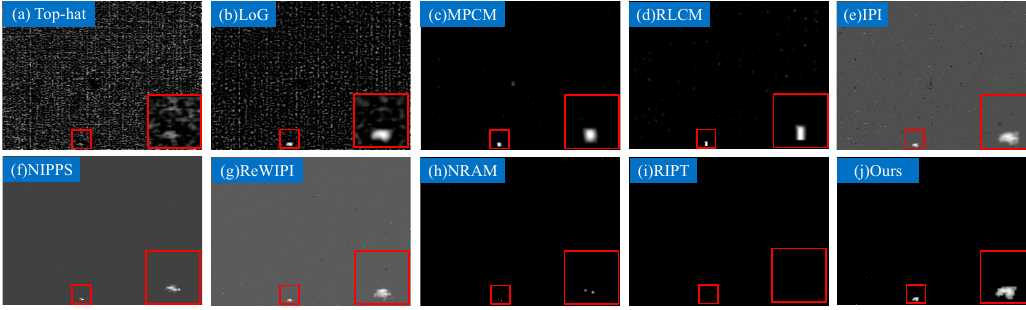
Figure 18. Results of the different approaches to Sequence 4.